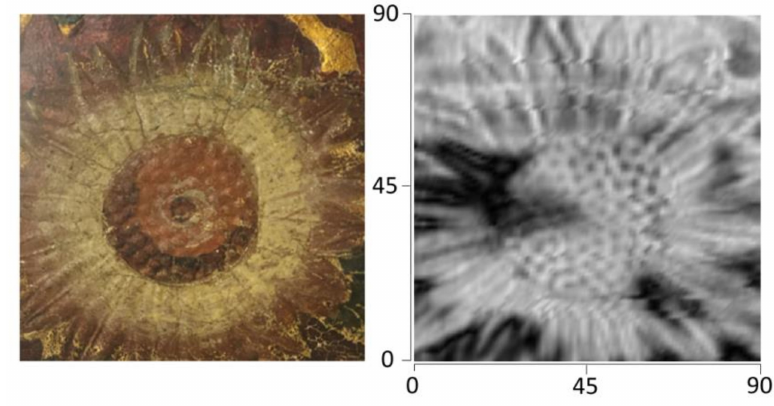
Figure 29. Visible image of a detail of leather wallpaper and the corresponding THz image.